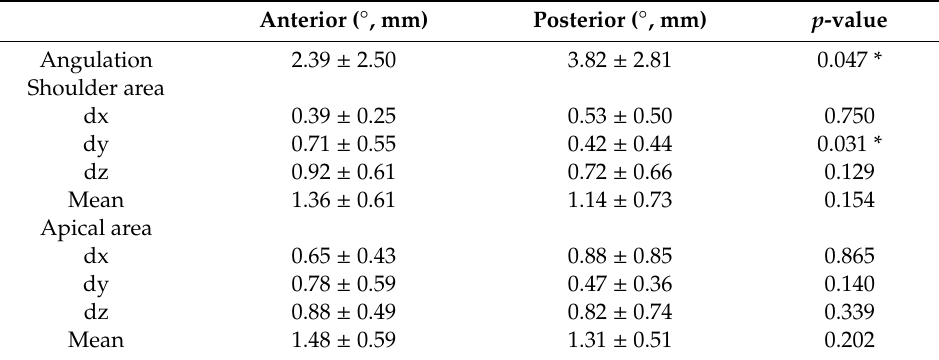
Table 7. Anterior vs. posterior (mean ± S.D.).